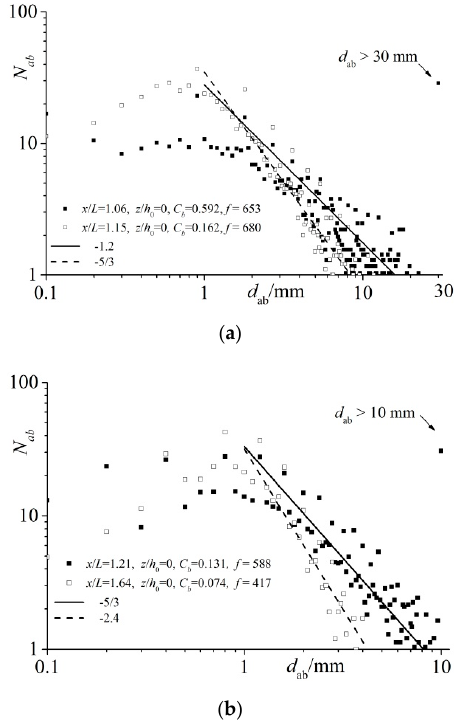
Figure 5. Bottom bubble chord length distributions in the impact zone ( a ) and equilibrium zone ( b ) (S5, V 0 = 8 m/s, F 0 =6.6).